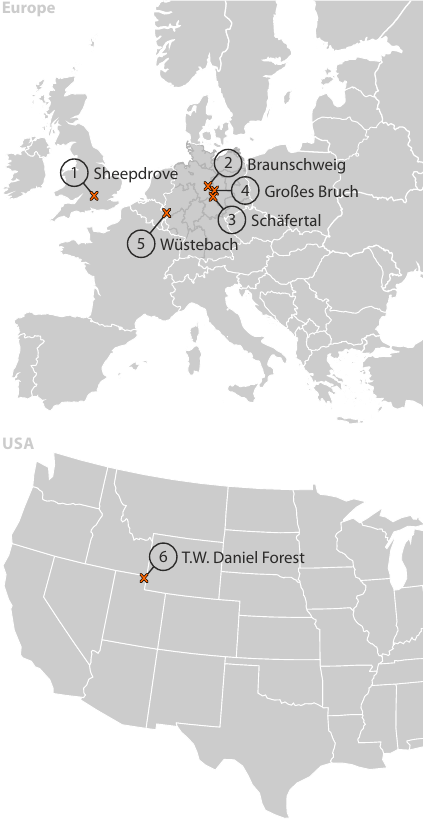
Figure 4. Selection of six distinct observation sites, five across Eu- rope, and one in Utah